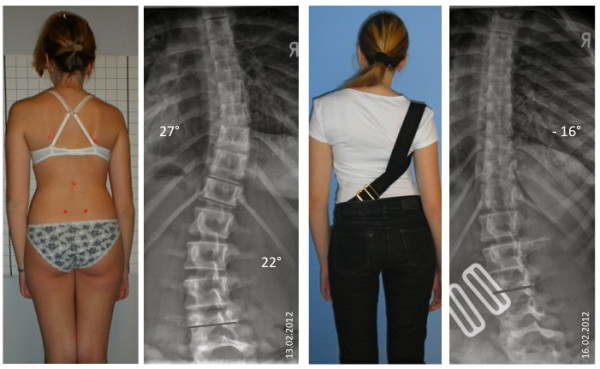
The patient presented in the case report in her Spinealite™ soft brace. Spinealite™ soft brace was adjusted leading to an overcorrection. The initial angle of curvature was 27° and in brace correction was −16°. The lumbar counter curve in frontal plane does not seem to be corrected much, however the axial load of this system when applied to the maximum correction obviously leads to an increased rotation. Therefore we would not allow the use of this system alone without hard brace and we will always propose regular clinical controls.